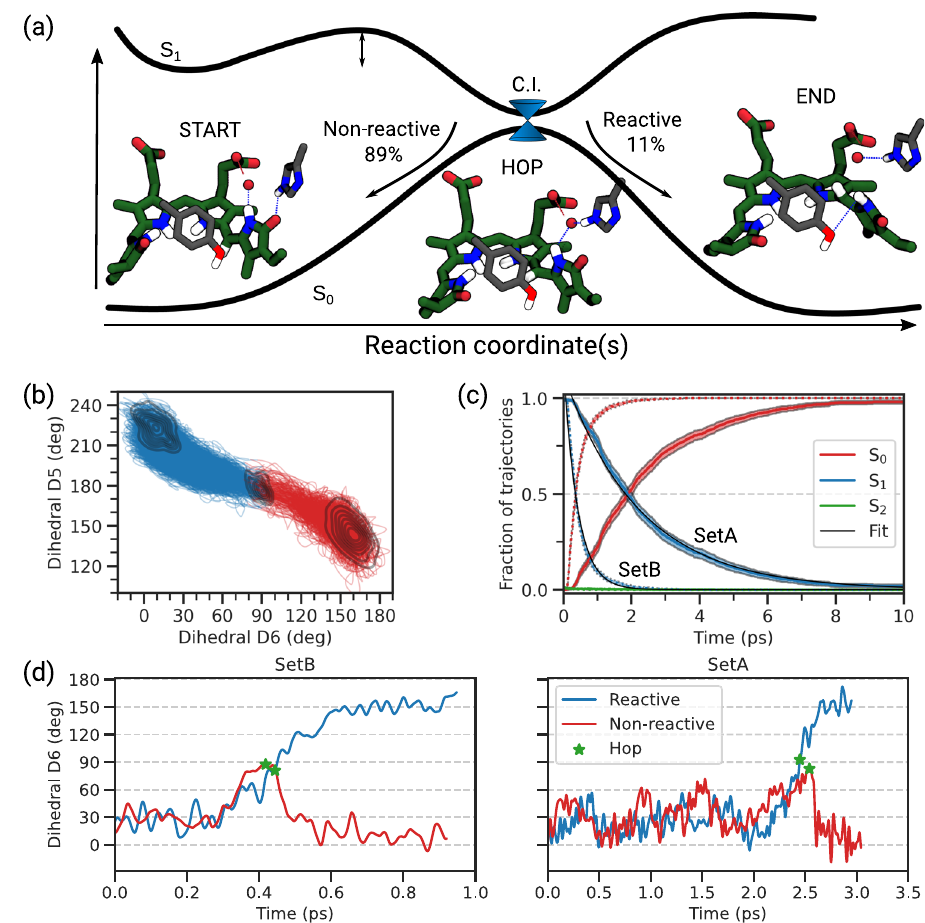
c Time evolution of the electronic state populations evaluated as the fraction of trajectories running on the given state at the given time for both Set A and Set B, whichare the meanvalues, withtheir 95% con fi dence intervals.Black line: fi t of the S 1 population according to an exponential function (Supplementary Methods 3). d Representative reactive and non-reactive SH trajectories from Set A and Set B. Green stars represent the S 1 -to-S 0 transition. Source data are available in the Zenodo repository 89